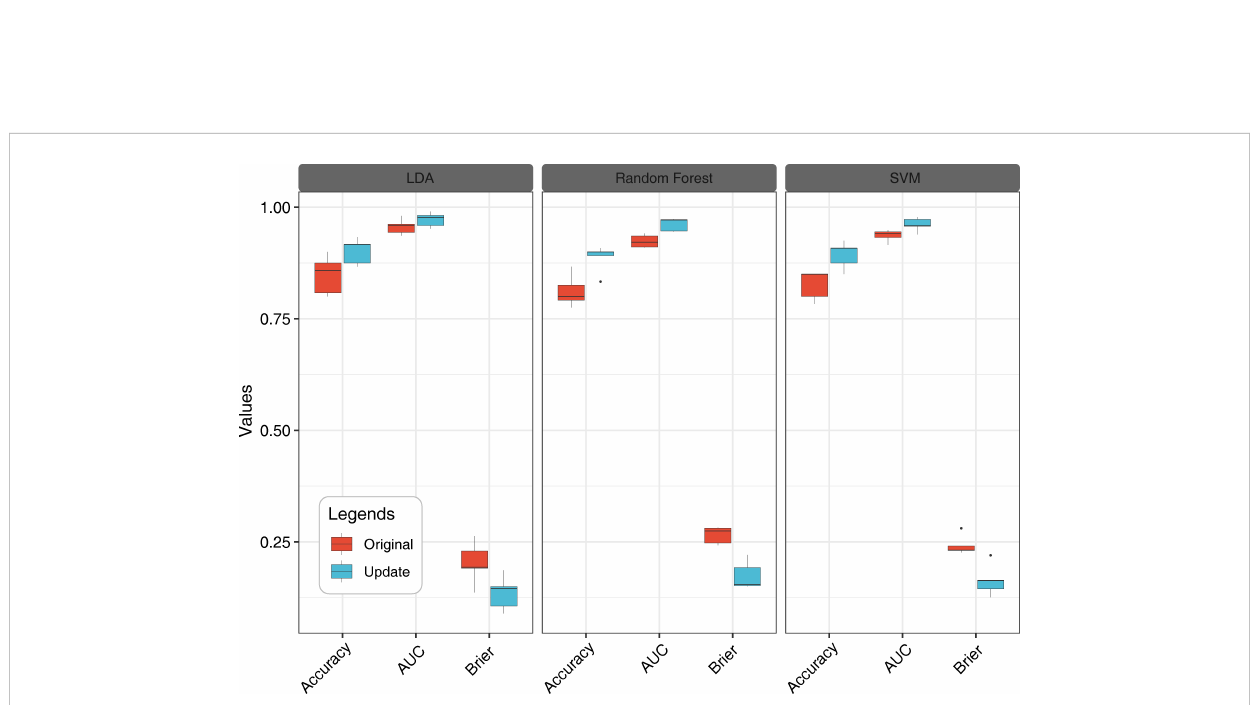
FIGURE 12 Accuracy of Siberian wild rye seed identi fi cation in three stages was improved by model update. Multi-source fusion data recognition models based on LDA, RF and SVM.